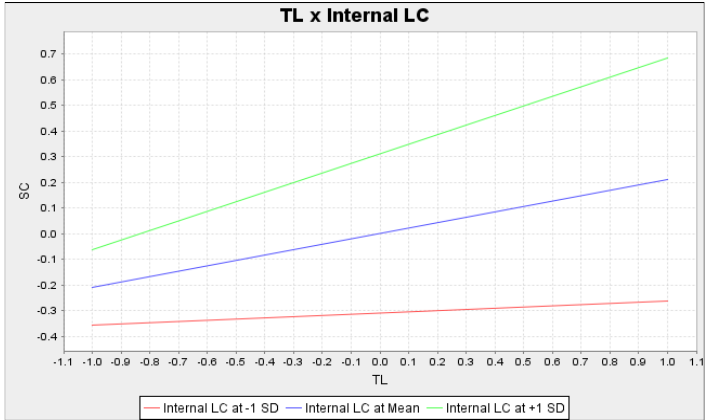
Figure 2: Moderating effect of LC between TL and SC.